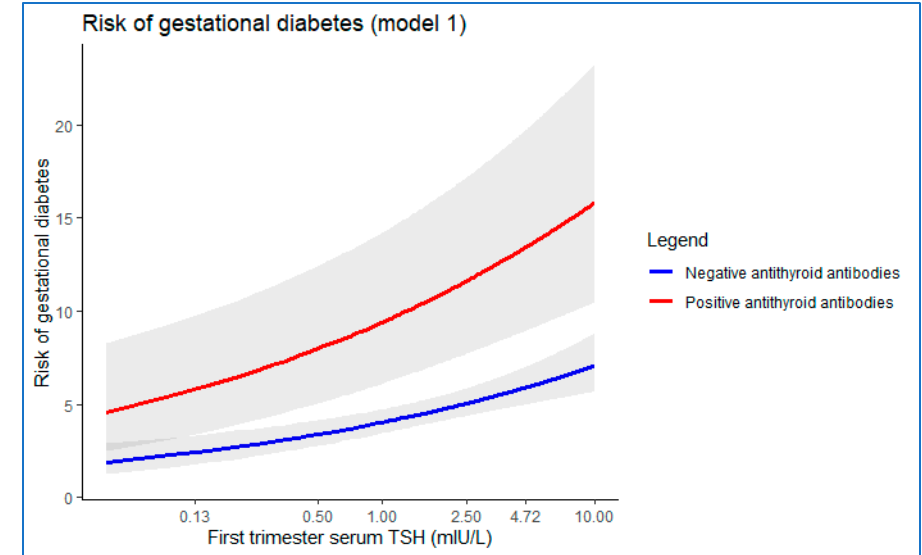
Figure 2. Risk of gestational diabetes mellitus predicted by model 1 for a representative 31-year-old patient, with no family history of type 2 diabetes mellitus, BMI between 18.5 and 24.99 kg/m 2 , and without chronic hypertension. Table 4. Multivariate logistic regression analysis including first trimester TSH as a categoric variable (Model